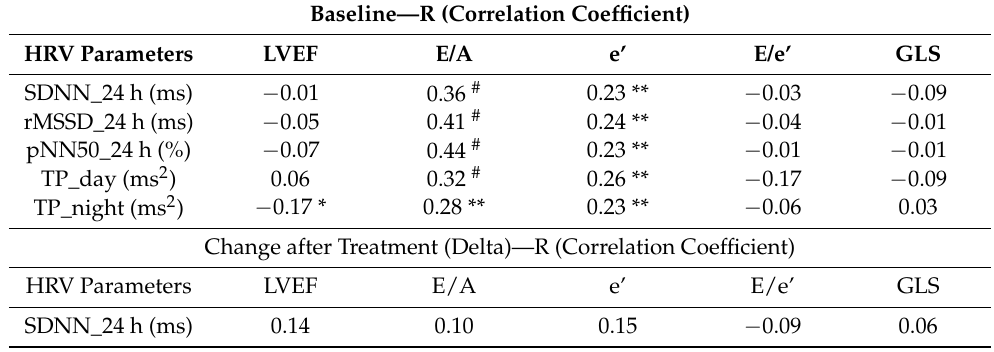
Table 3. Correlations of heart rate variability parameters with echocardiographic parameters of LV systolic and diastolic function for baseline absolute values and changes (delta) after 12-month